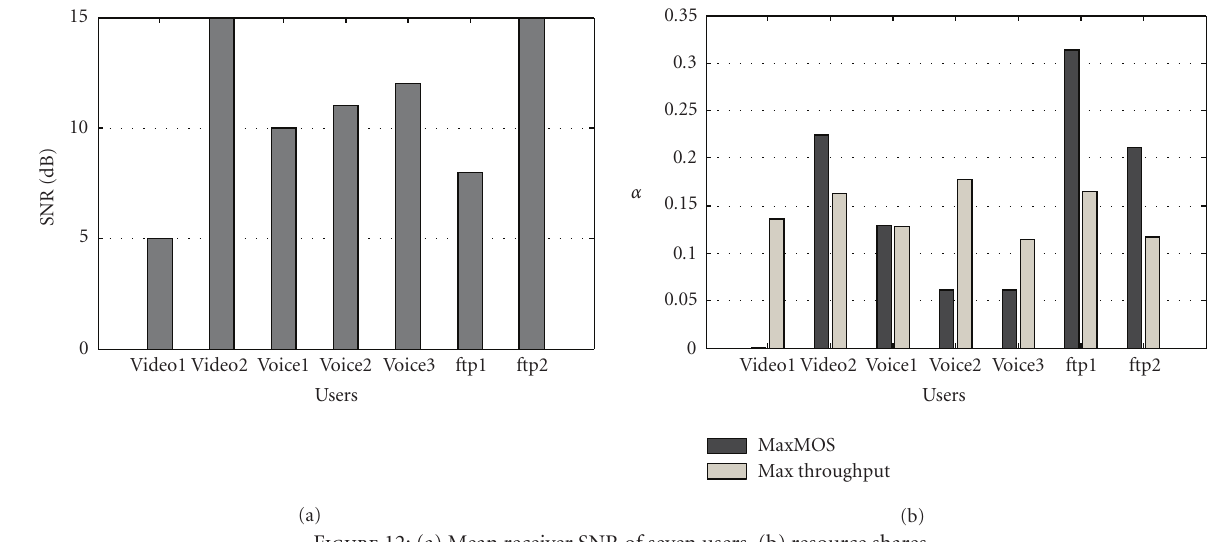
Figure 12: (a) Mean receiver SNR of seven users, (b) resource shares.